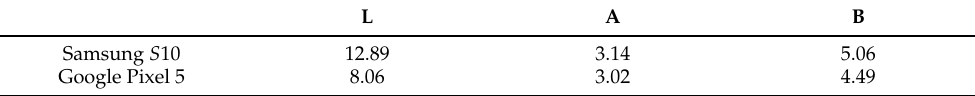
Table 4. Average weight difference between Nix Pro data and image